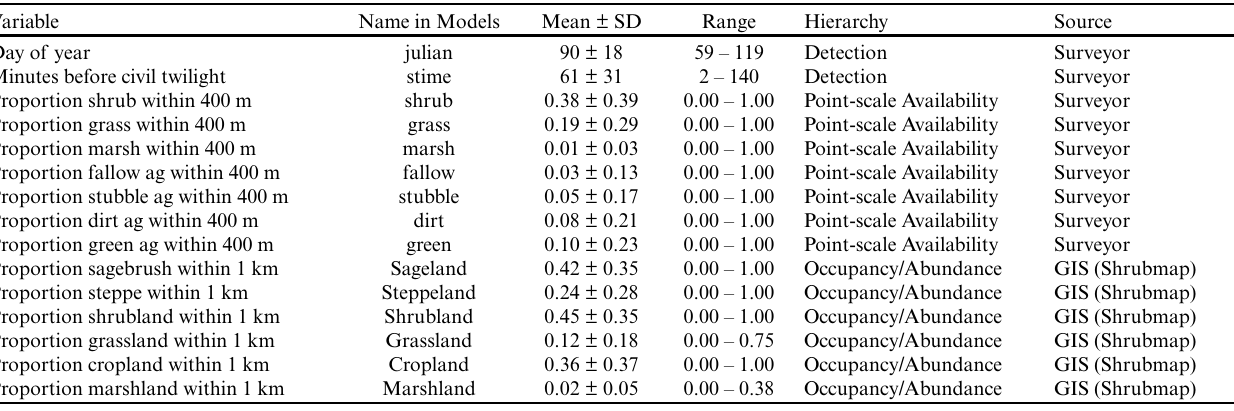
Table 1 . Definition, variable name used in models, mean, standard deviation (SD), range, position within multiscale hierarchy, and source of covariates evaluated for influence in occupancy and abundance analysis of Short-eared Owls ( Asio flammeus ) within Idaho during the 2015 breeding